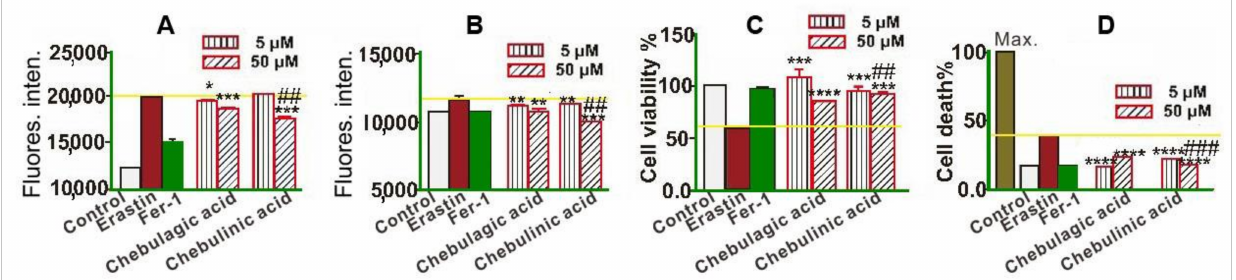
Figure 3. ( A ) BODIPY-probed flow cytometry analysis; ( B ) H2DCFDA-probed flow cytometry analysis; ( C ) cell counting kit-8 (CCK-8) analysis; ( D ) lactate dehydrogenase (LDH) release analysis. Control group, bmMSCs without erastin treatment; erastin group, 10 µ M erastin-treated bmMSCs; Fer-1 group, bmMSCs treated with 10 µ M erastin + 1 µ M Fer-1; chebulagic acid group, bmMSCs treated with 10 µ M erastin + chebulagic acid; chebulinic acid group, bmMSCs treated with 10 µ M erastin + chebulinic acid. Data are presented as mean ± SD from three independent experiments. * p < 0.05, ** p < 0.01, *** p < 0.001, **** p < 0.0001 compared with the model group; ## p < 0.01, ### p < 0.001 compared with the chebulagic acid group at the same